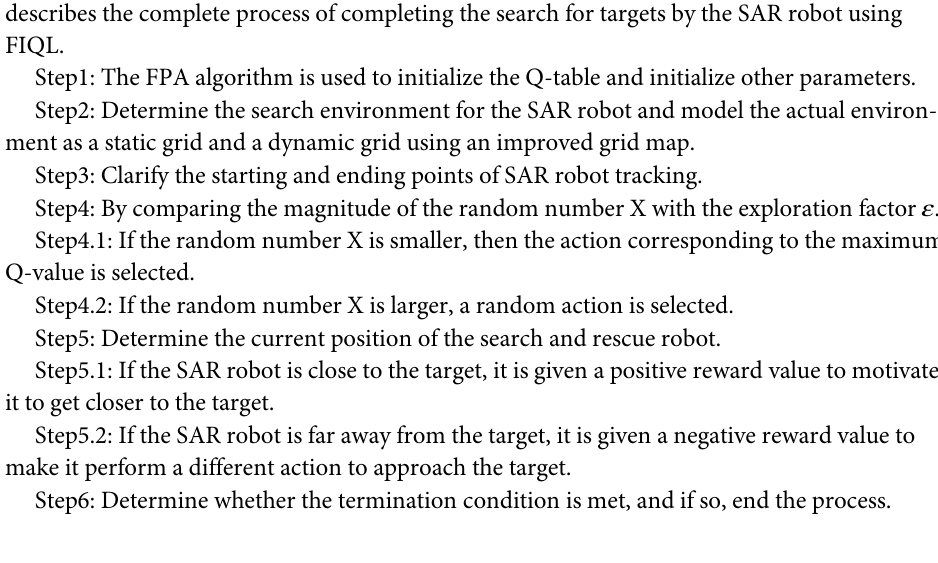
Table 1. Parameter settings of FIQL, CQL, PSO, GWO and DA.